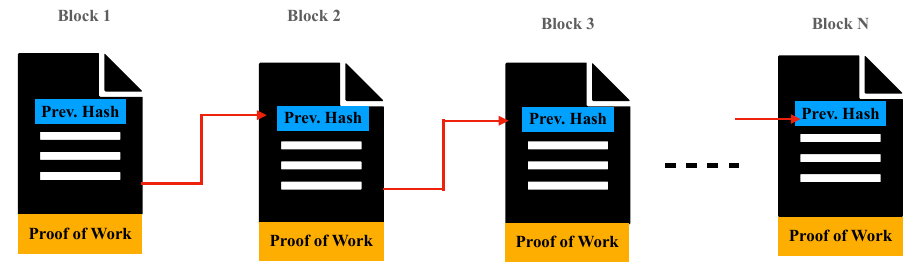
Figure 1. Blockchain